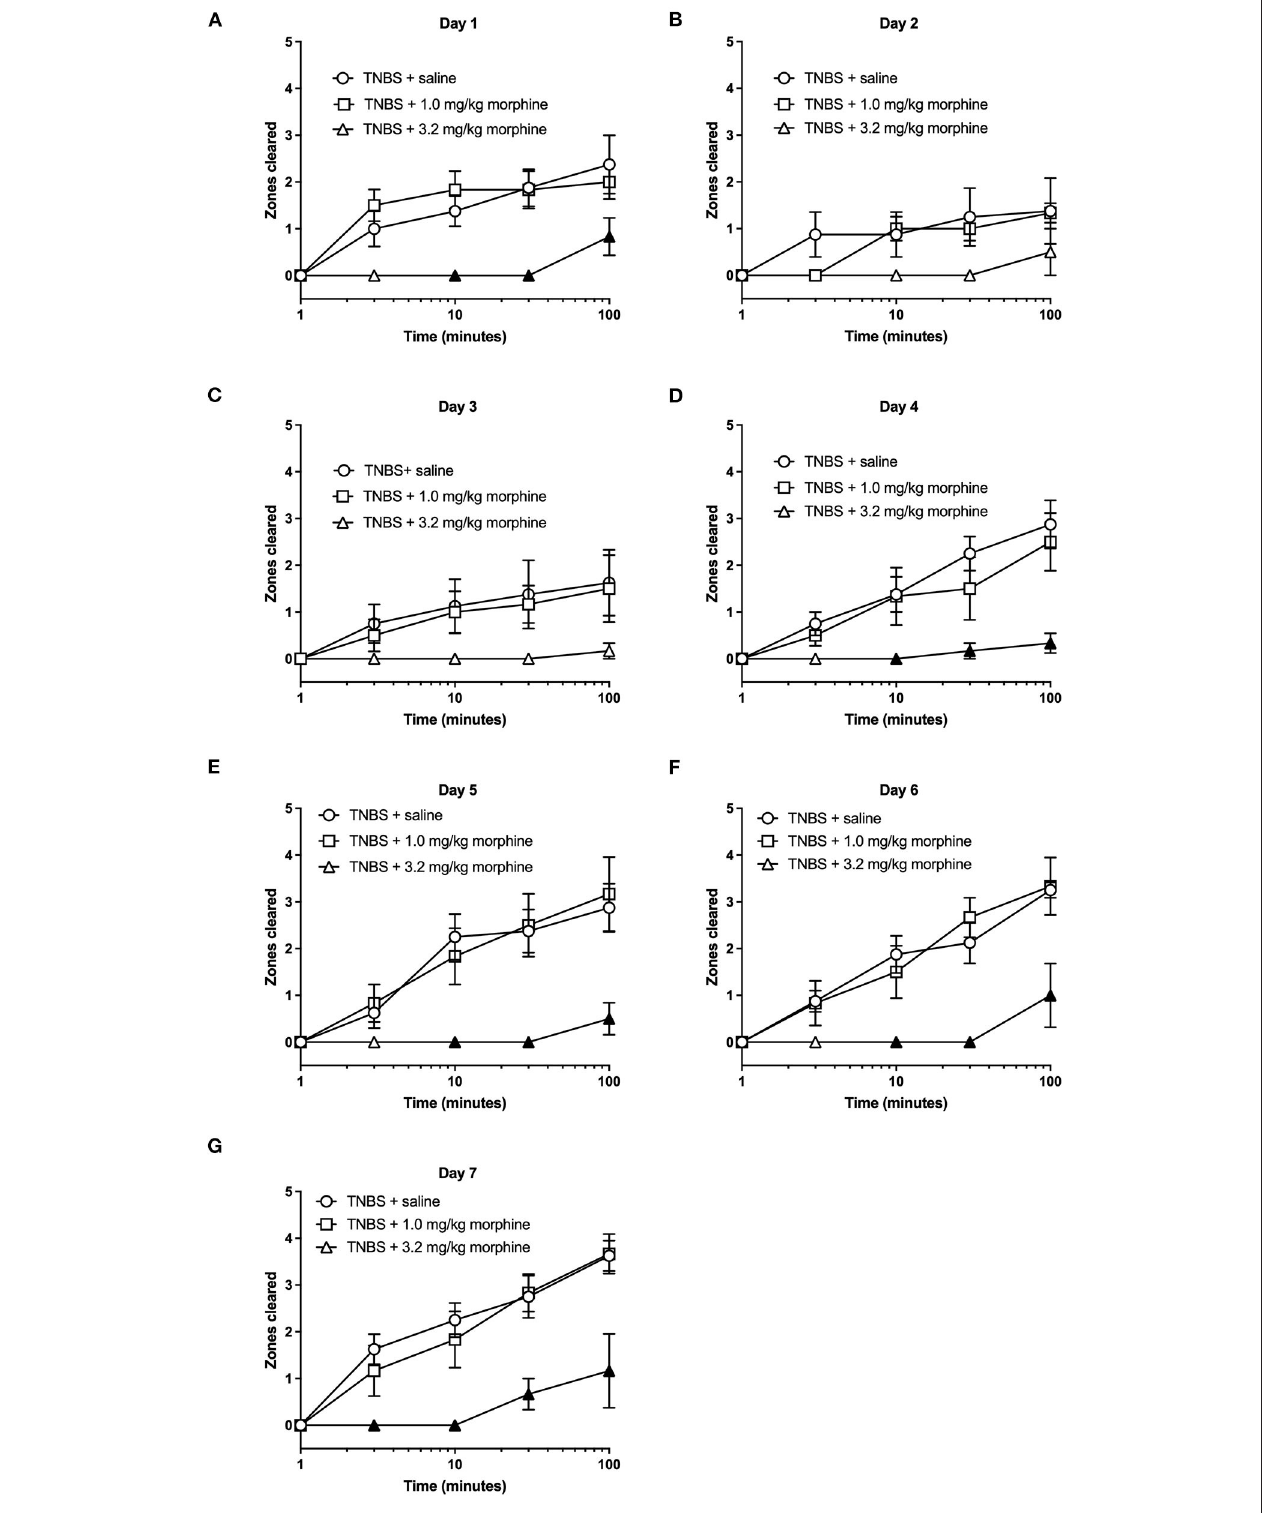
FIGURE 8 | The effect of repeated morphine treatment on TNBS-induced depression of nesting. (A–G) show zones cleared at 1, 3, 10, 30, and 100min in mice treated daily with saline or morphine (1.0, 3.2 or 10 mg/kg/day) on Days 1–7, respectively. Nesting scores were recorded 30min after saline or morphine treatment. Compared to saline, 3.2, but not 1.0 mg//kg/day morphine significantly exacerbated TNBS-induced depression of nesting and prevented recovery of nesting behavior.